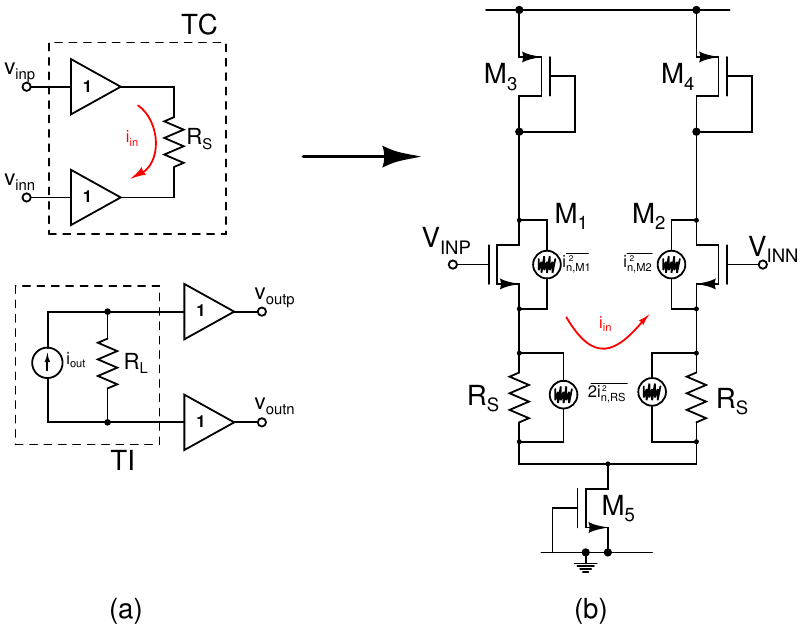
Figure 8. Current-mode amplifier model. ( a ) Architecture ( b ) schematic of the input TC with noise sources.